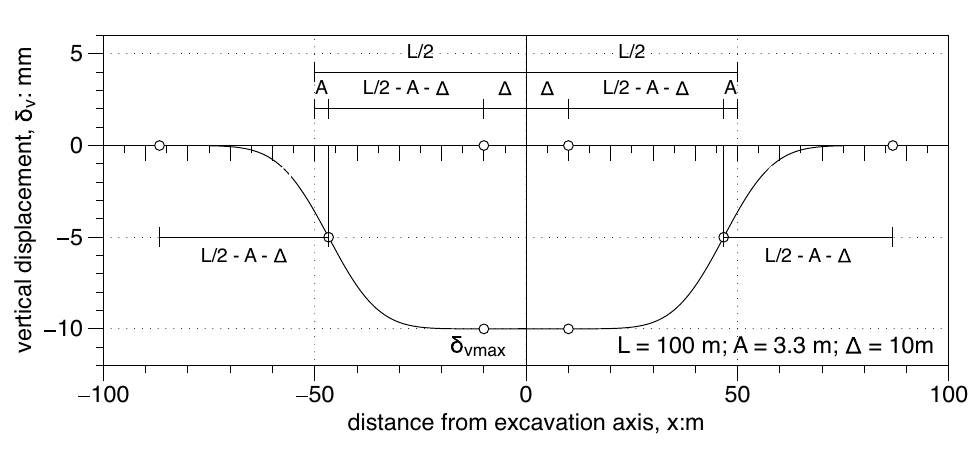
Figure 5. Settlement profiles in the direction parallel to the wall (Russo et al. 11 , � > 0